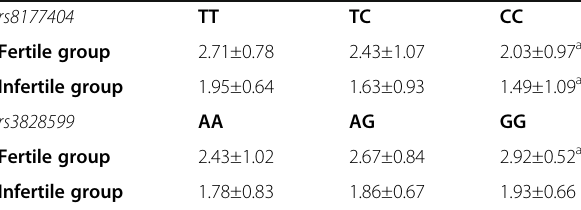
Table 7 Seminal fluid levels of glutathione peroxidase 3 (ng/ml) according to the various genotypes of rs8177404 and rs3828599 polymorphisms in fertile ( n =100) and infertile group ( n =100)